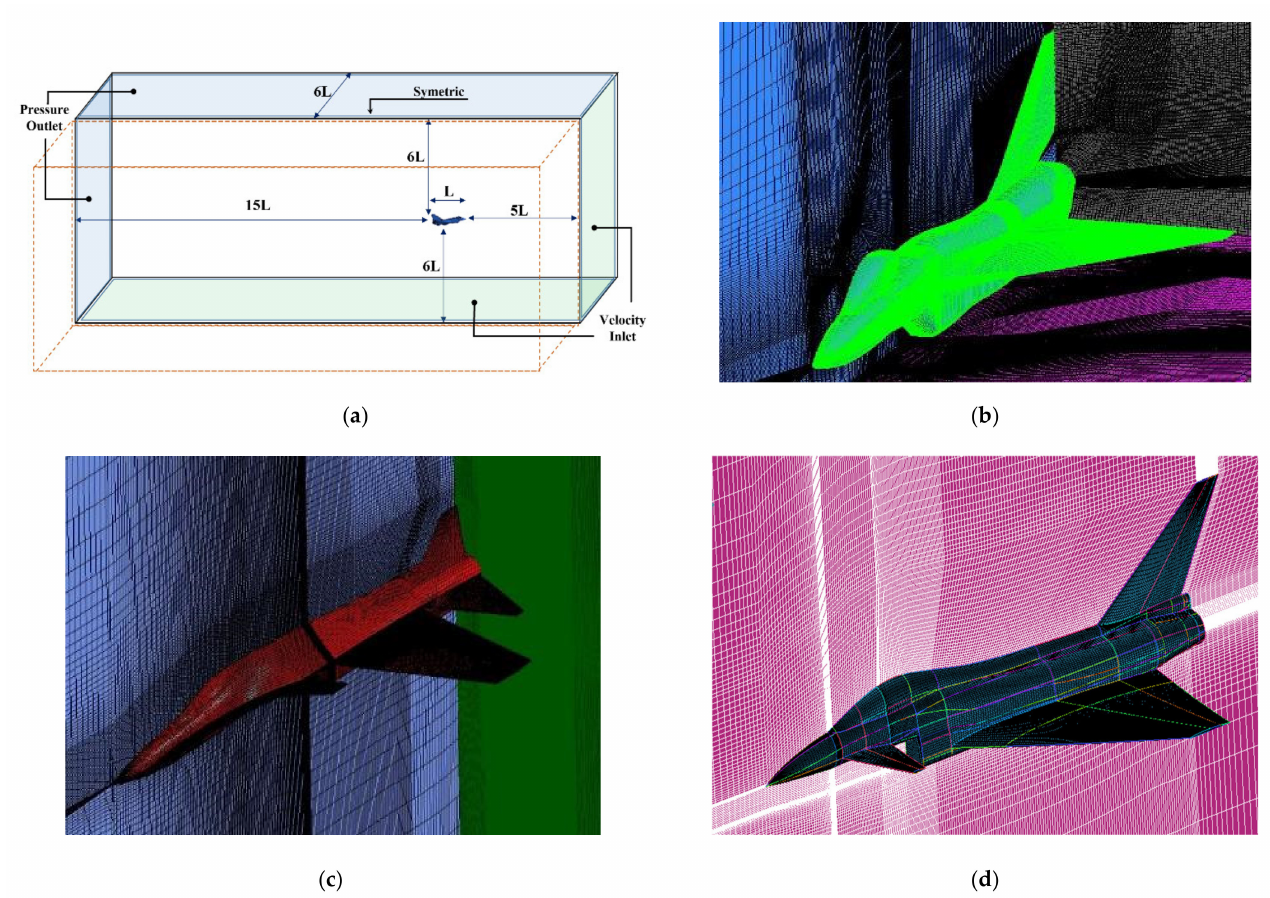
Figure 3. Domain configuration, boundary conditions, and computational mesh for each aircraft model; ( a ) Domain and boundary condition;( b ) J-10 meshing; ( c ) SU-30 meshing; ( d ) EF-T